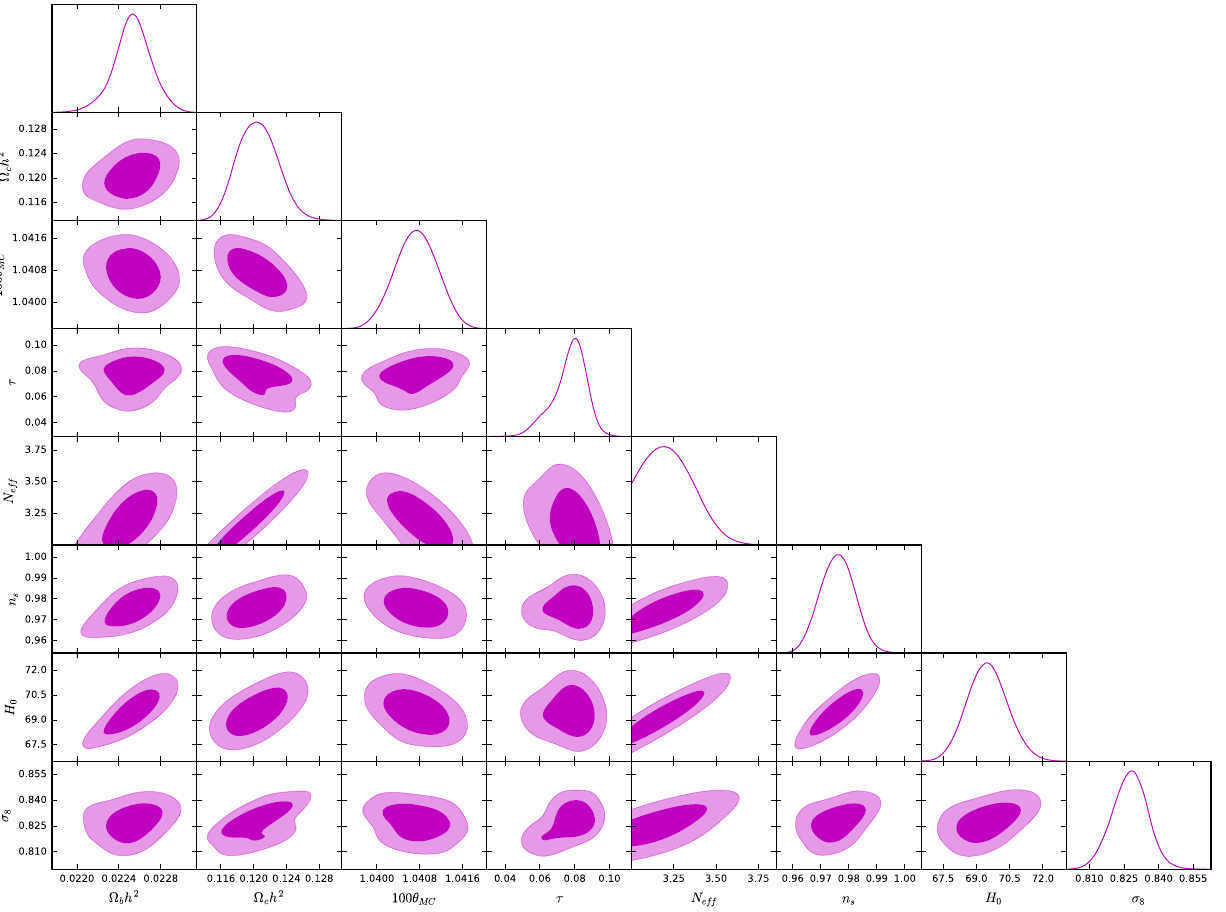
Fig. 3 The 1-dimensional marginalized distributions and 2-dimensional contours for the parameters of the Fs model by using the data combination